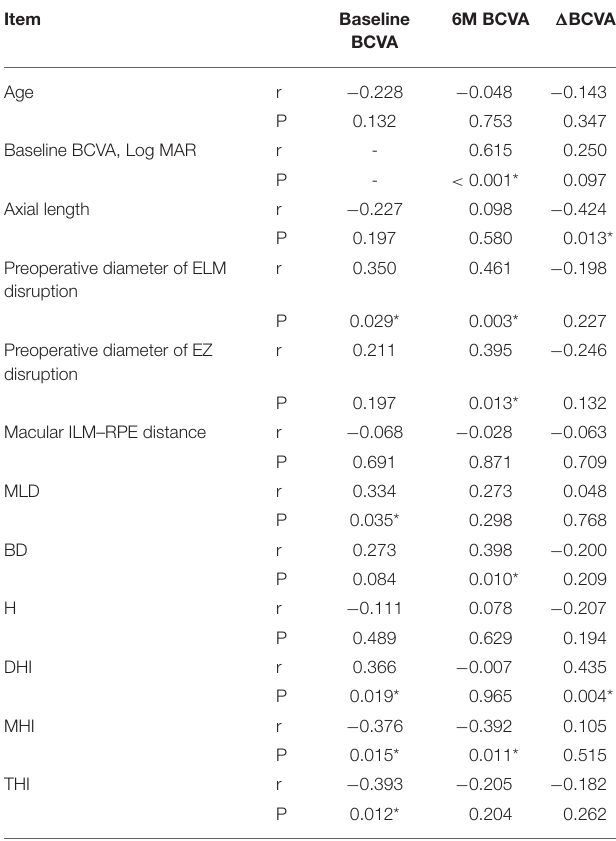
TABLE 4 | Spearman’s correlation analysis between preoperative factors and baseline BCVA, 6-month postoperative BCVA and 1 BCVA.